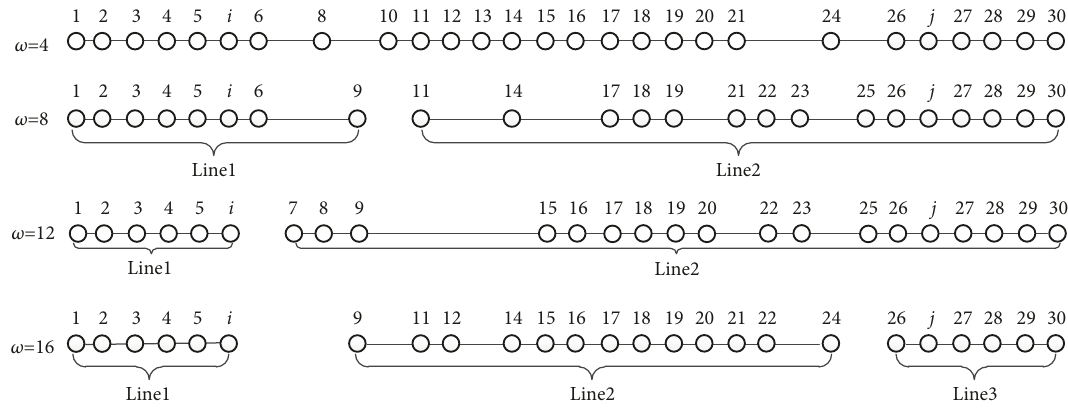
Figure 10: The optimal forms of the target bus line under different values of 𝜔 .